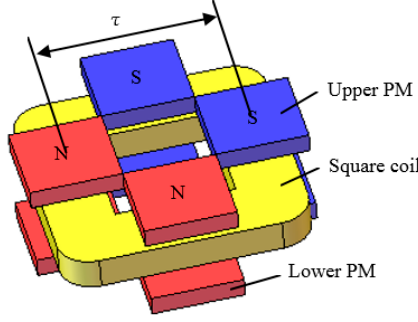
Figure 2. Lorentz ‐ force ‐ driven unit. (PM: Permanent Magnet).